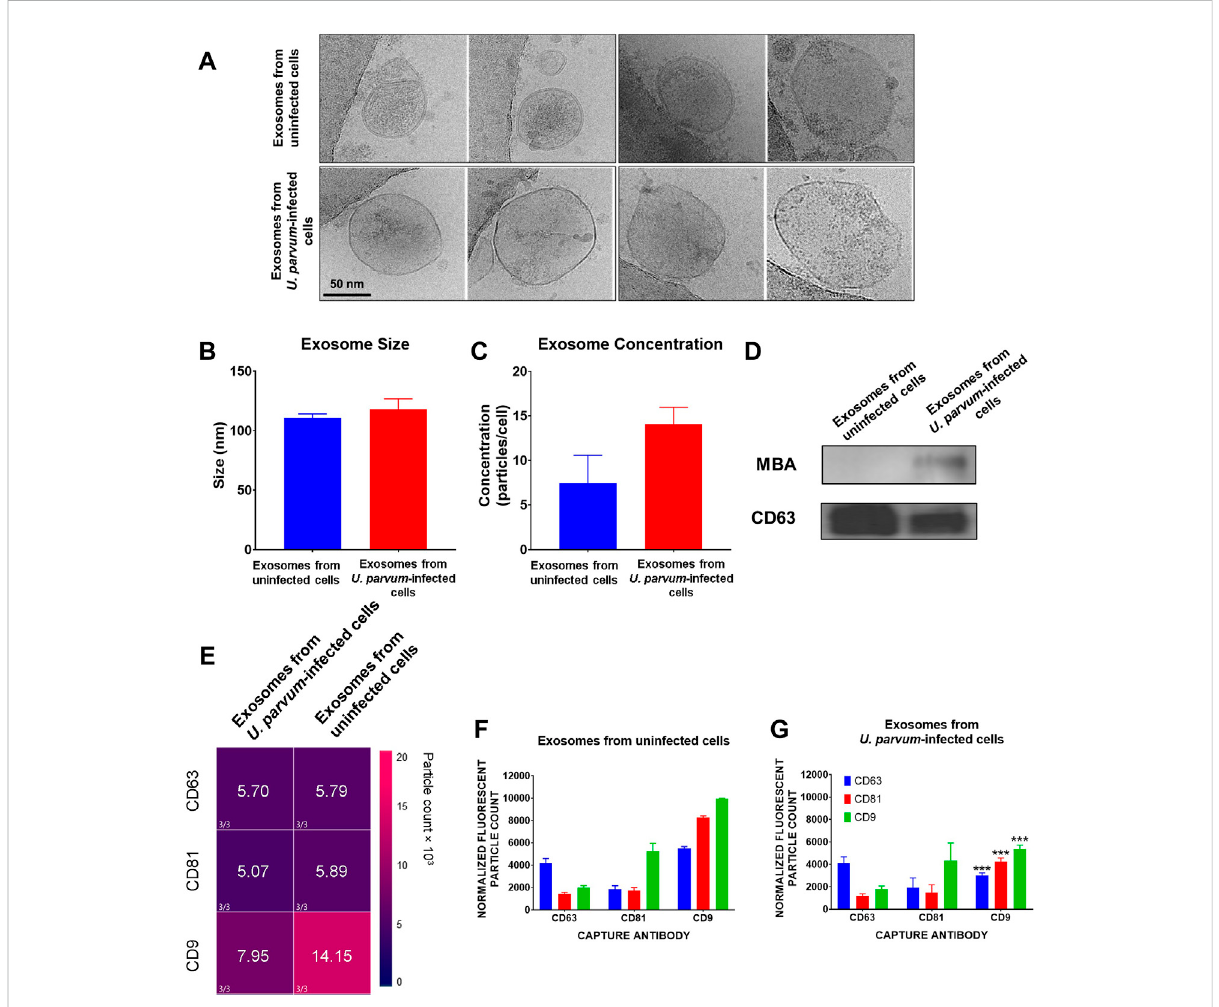
FIGURE 2 Characterization of exosomes from ECTO cells infected with U. parvum . (A) Cryo-electron micrograph of cervical exosomes shows circular exosomes. Scale, 50 nm. (B,C) Nanoparticle tracking analysis of cervical exosomes did not show signi fi cant differences in exosome concentration (particles/cells) and exosome size of exosomes from uninfected and U . parvum -infected ECTO cells. (D) All cervical exosomes expressed the exosomes marker, CD63. However, only the exosomes from infected cells expressed MBA via western blot. Error bars represent median ± SD. n = 3 technical replicates. (E,G) ExoView analysis of exosomes from uninfected vs., U . parvum -infected ectocervical epithelial cells. (E) Heat map showing the normalized expression of tetraspanin markers in ECTO cell exosomes. (F,G) ExoView counts of immuno fl uorescent stained positive exosomes for all tetraspanin markers detected. The data are presented as the means ± SEM. *** p <